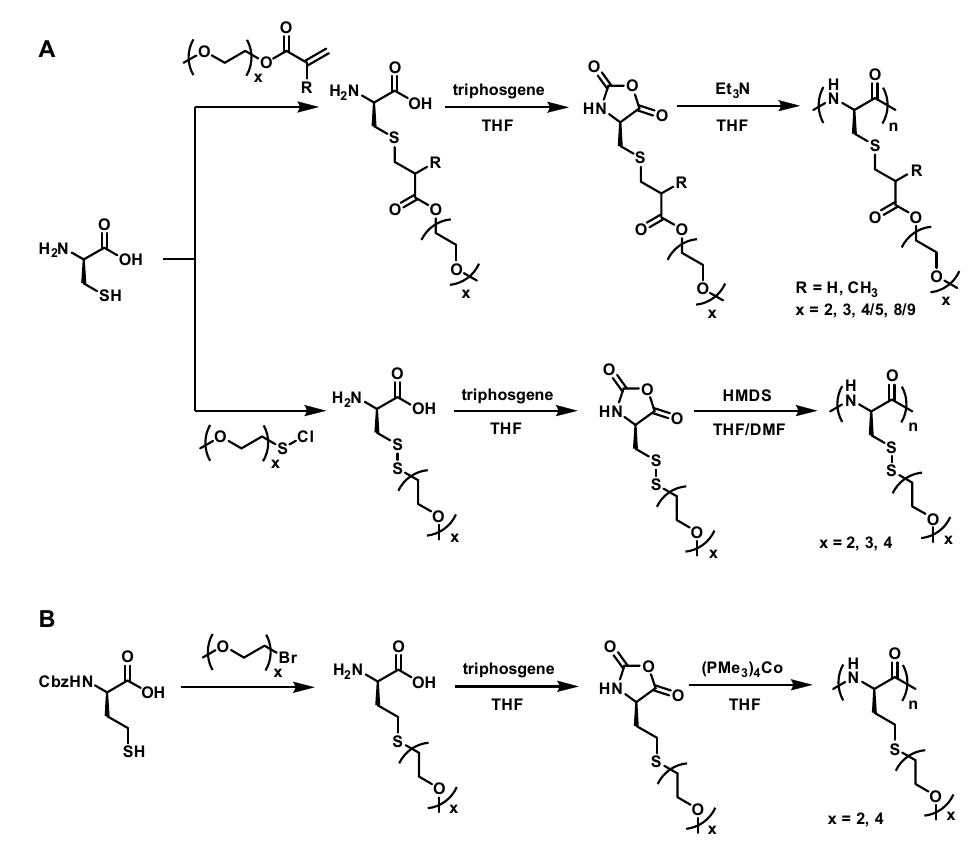
Figure 6. Synthetic routes to OEGylated poly(amino acid)s from cysteine/homocysteine by ( A ) Li’s group [35,36], and ( B ) Deming’s group [28].